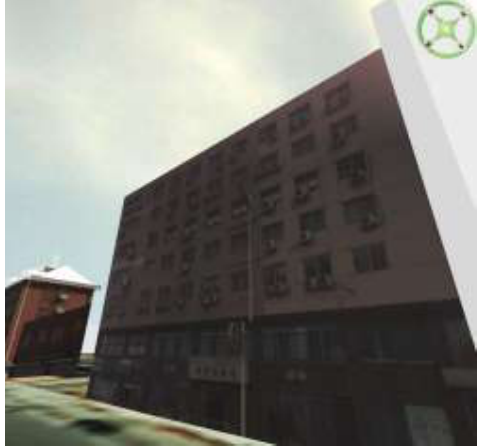
Figure 5. Detail of the texture extracted from